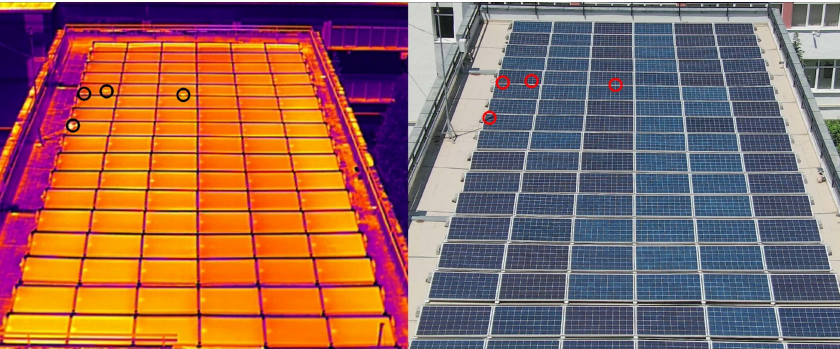
Figure 8. Thermal scanning using drone inspection displays the hot spot on the PV farm. The PV solar park configuration on the building rooftop is made of 102 panels with 60 cells each, obtaining a total of 6120 cells. We identified 3 panels with faulty cells caused by solar anomalies and a total of 8 cells were identified as faulty, which means 99.87% of the park is working properly. This kind of defect is hard to spot using traditional methods, that require an actual technician to manually check every panel and cell to pinpoint the faulty ones. By using the thermal vision camera, defective cells have a higher electrical resistance which converts power into heat. Hence, on the visual spectrum, the faulty cells will look brighter or darker. For very big areas of PV plants, artificial intelligence algorithms are used to count the faulty cells based on the input pictures captured with drones. In our case, a grid matrix is applied to inspect the 60 solar cells of each PV panel. A closer view inspection reveals the 8 brighter faulty cells that are present on the PV farm (i.e., on the 3 solar panels), as illustrated in Figure 9.